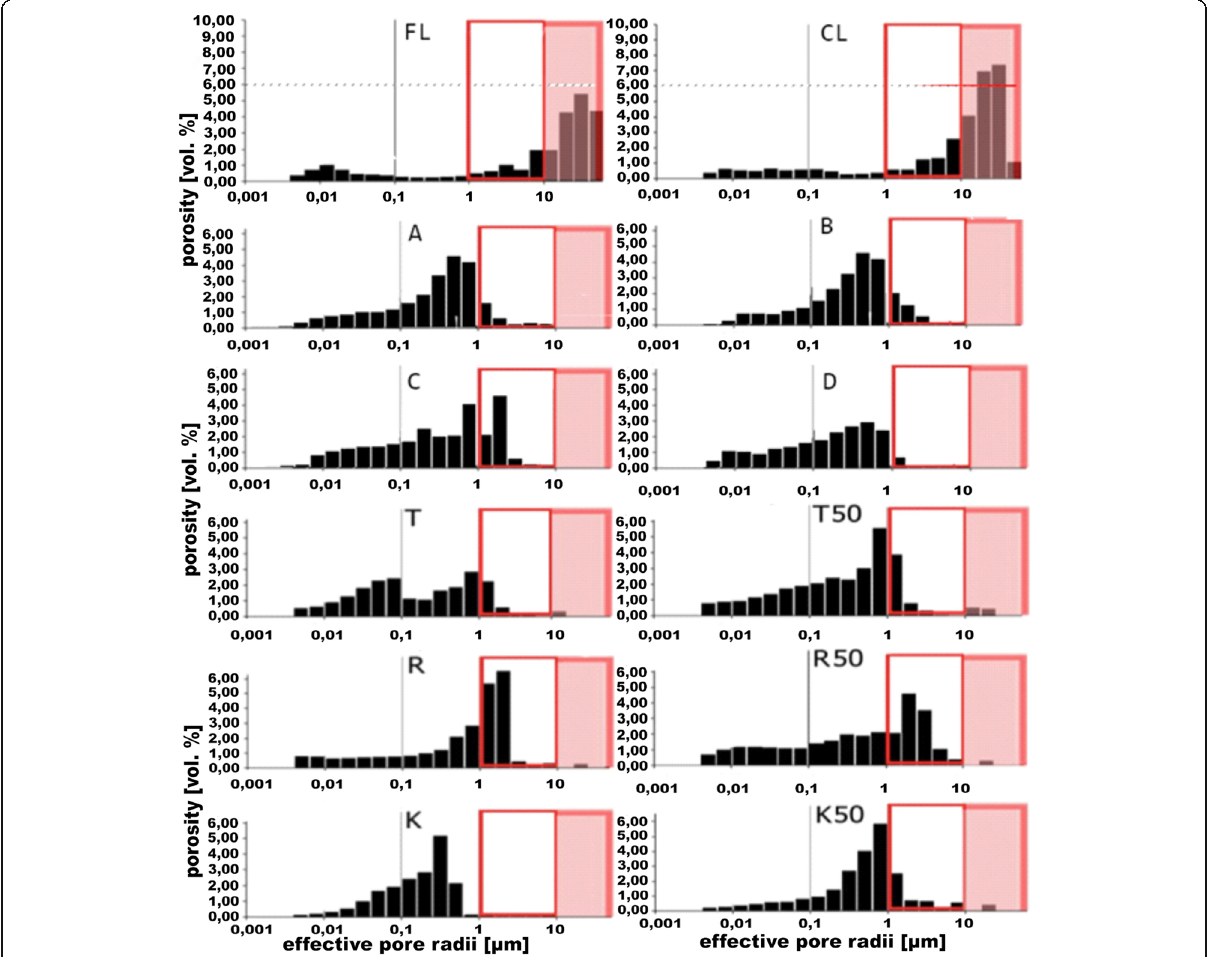
Fig. 3 Pore size distribution of the tested specimens. FL and CL are porous limestone and A, B, C, D, T, T50, R, R50, K, and KR50 are repair